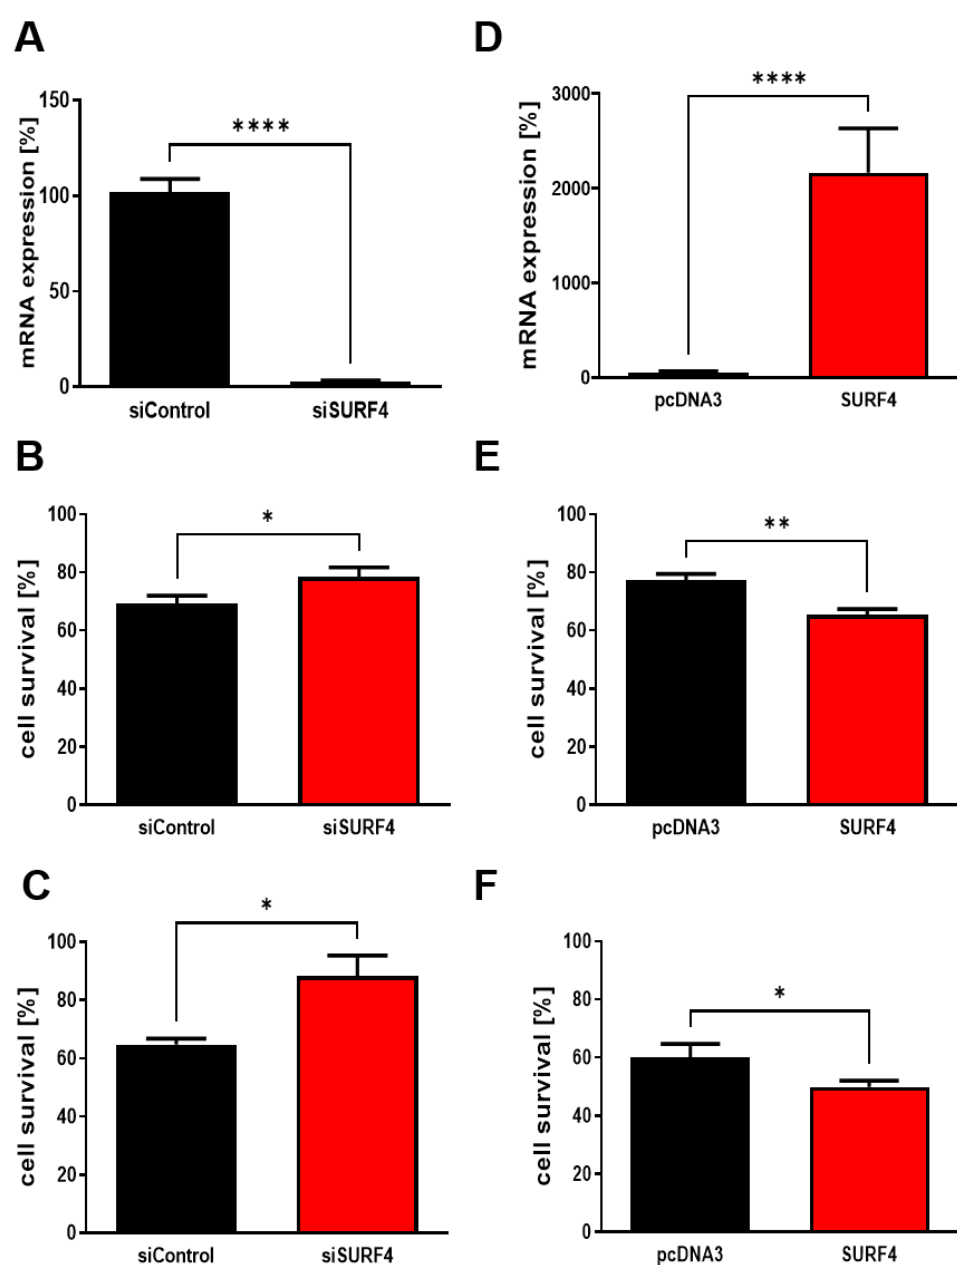
Figure 6. SURF4 contributes to A β 1–42 toxicity on neuroblastoma cells. ( A ) Human neuroblastoma cells were transfected with SURF4 siRNA or with a non-active control siRNA, and after 48 h the levels of SURF mRNA were quantified by semi-quantitative rtPCR. Data are the mean ± SEM of 3 independent experiments. **** p < 0.0001 vs. control by Student’s t-test. ( B , C ) Cells transfected with SURF4 siRNA were treated with 5 µ M ( B ) or 10 µ M ( C ) oA β 1–42 for 24 h. Data are the mean ± SEM of 3–10 independent experiments. * p < 0.05 vs. control by Student’s t-test. ( D ) Human neuroblastoma cells were transfected with a plasmid containing the sequence of human SURF4 or with a non-coding control ( pcDNA3 ), and after 48 h the levels of SURF mRNA were quantified by semi-quantitative rtPCR. Data are the mean ± SEM of 3 independent experiments. **** p < 0.000 1 vs control by Student’s t-test. ( E , F ) Cells transfected with the plasmid to overexpress SURF4 were treated with 5 µM ( B ) or 10 µM ( C ) oA β 1 – 42 for 24 h. Data are the mean ± SEM of 4 independent experiments. ** p < 0.01 and * p < 0 .5 vs control by Student’s t -test.